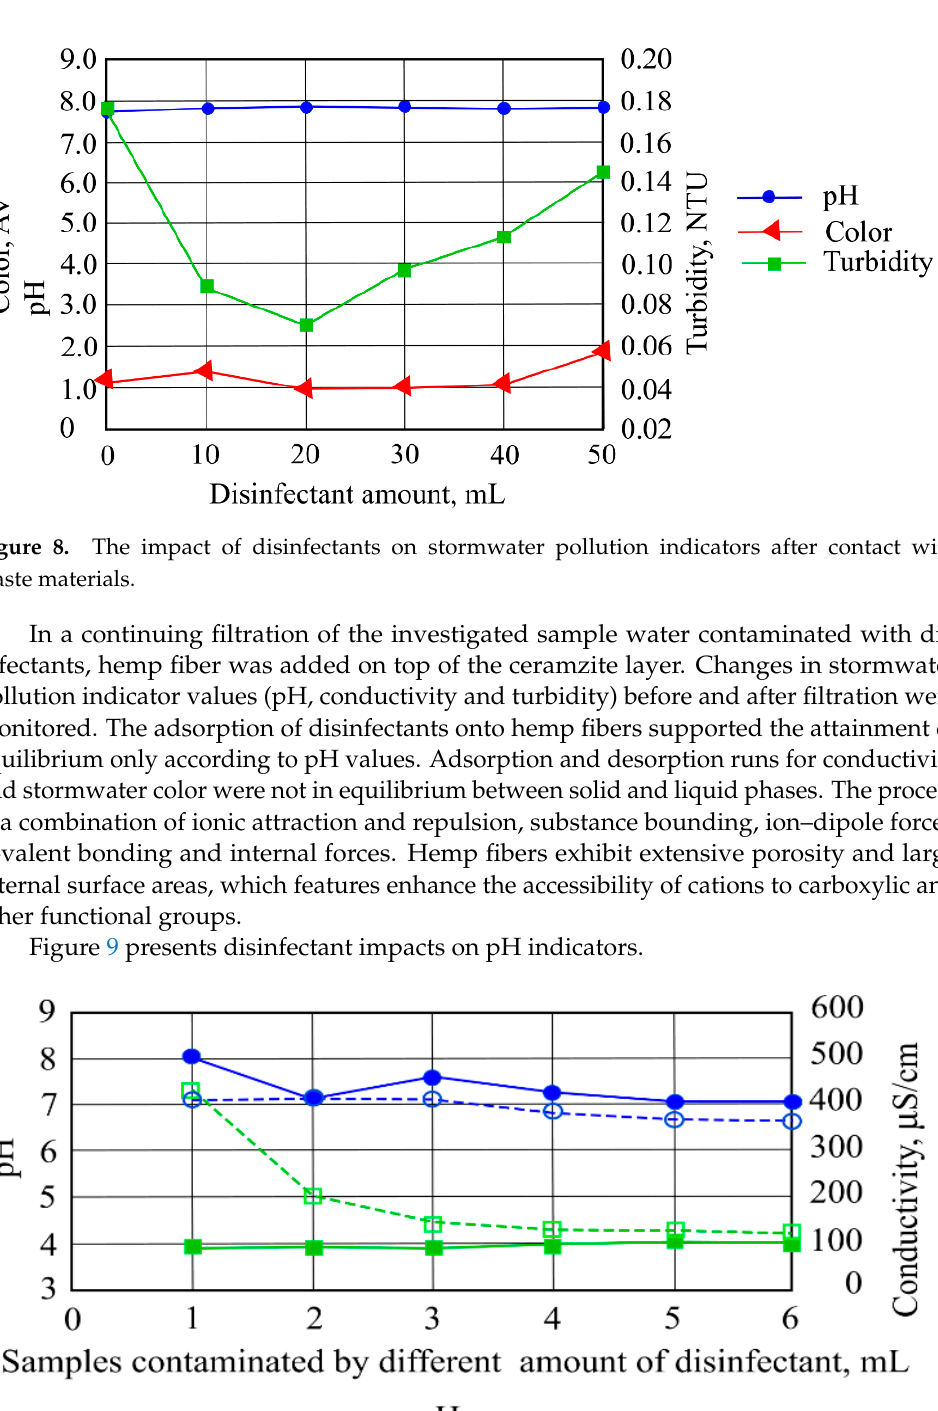
Figure 7. The impact of disinfectants on conductivity.